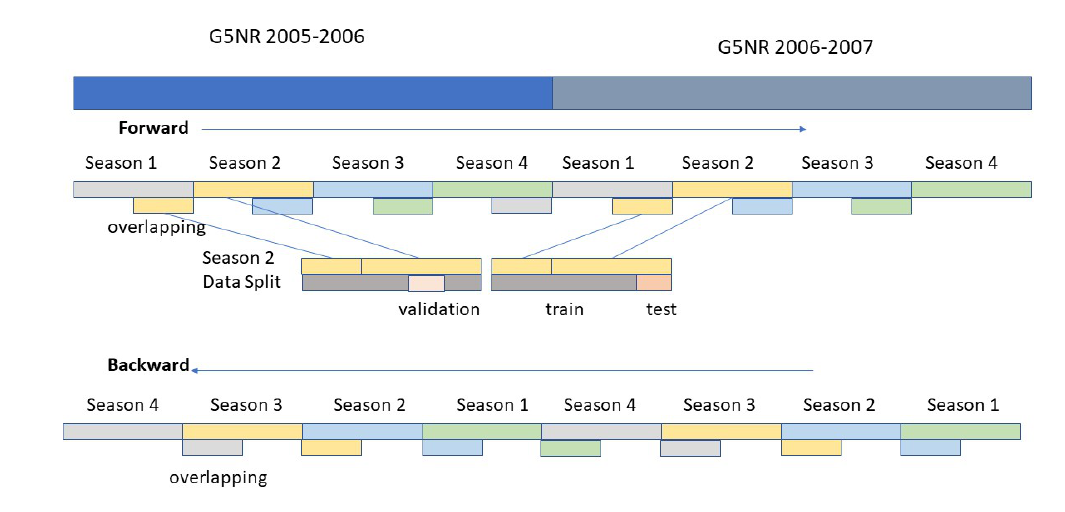
Figure 4. Temporal simplification and splitting for forward and backward